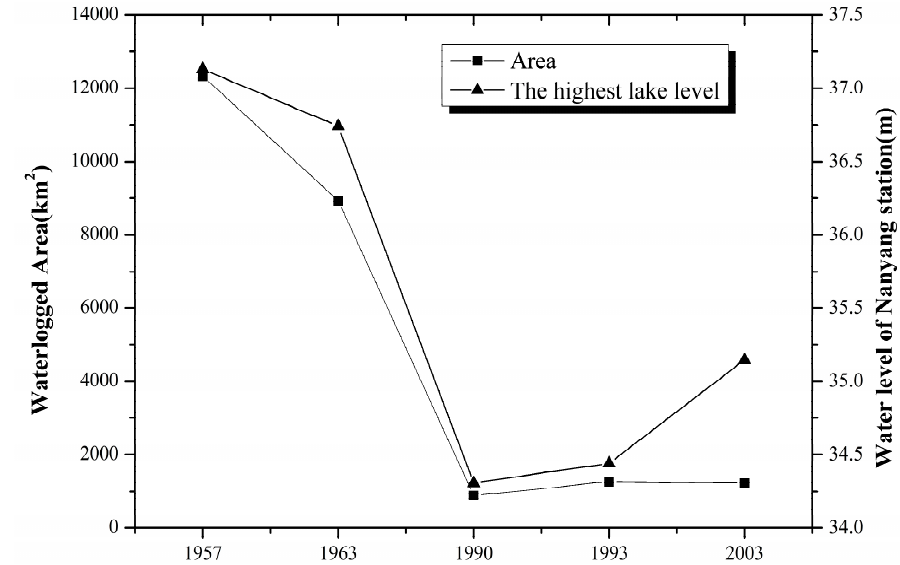
Figure 6. The comparison of the change trends of the waterlogging area and the highest water level at Nanyang station.